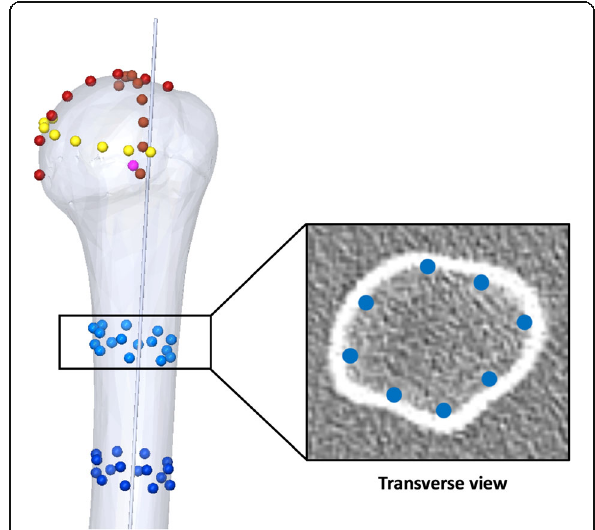
Fig. 1 Determination of the humeral head center coordinates by digitizing 3 series of 8 points on the head surface ( ‘ sphere of best fit ’ method), and determination of the intra-medullary canal axis and width by digitizing 4 series of 8 points on transverse sections 65, 70, 100 and 105 mm below the head center ( ‘ cylinder of best fit ’ method)